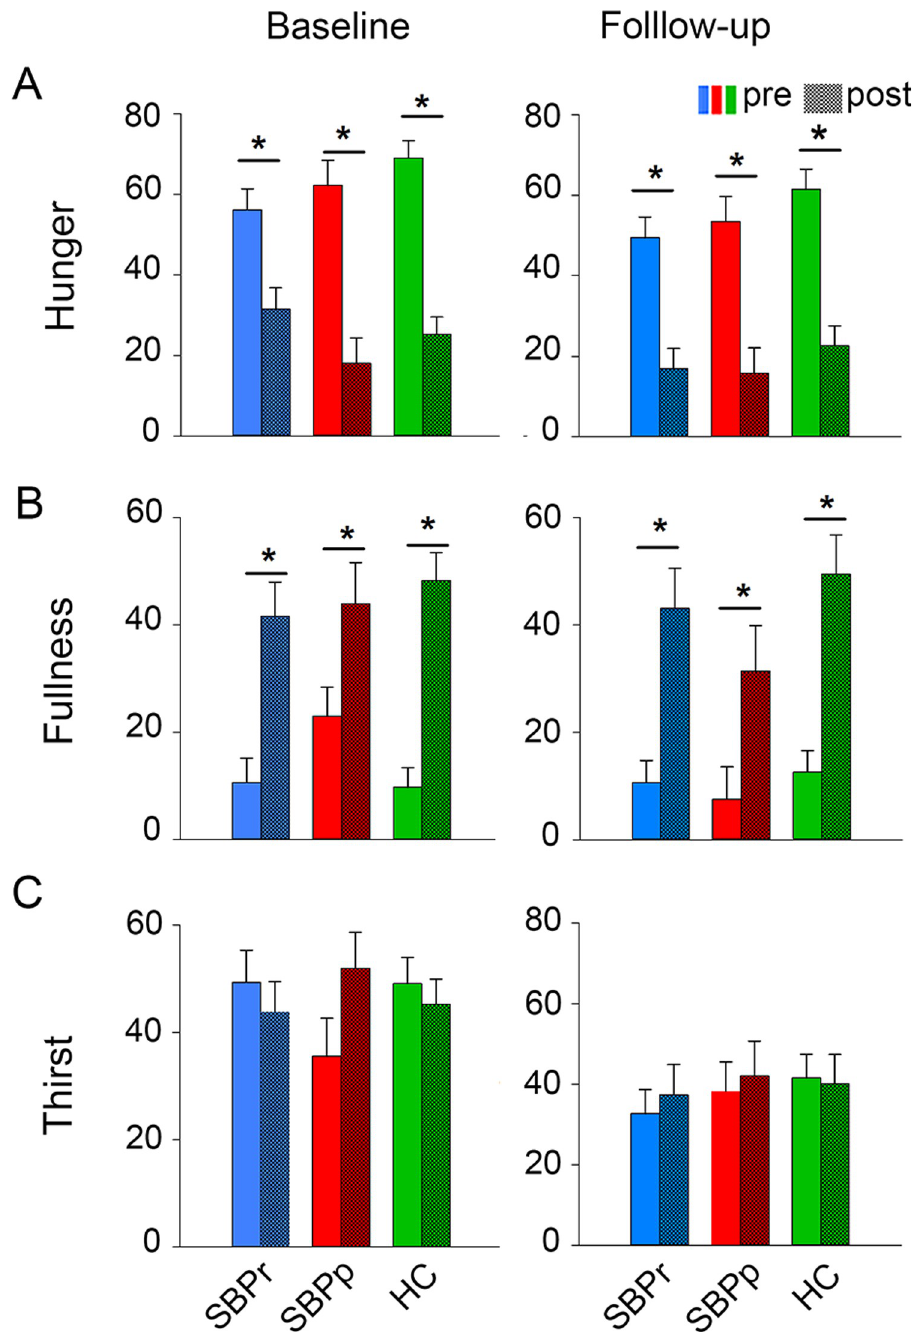
Fig 4. Internal state ratings before and after the ad libitum consumption of the preferred pudding during session 2. ( A ) Hunger, ( B ) Fullness, and ( C ) Thirst rated by SBPr, SBPp and HC (baseline, left; follow-up, right). There were no time or group effects in any of the analyses. Hunger and fullness ratings changed significantly after pudding consumption in all groups ( A-B ); thirst ratings did not differ following between groups or after consumption. There was no group or interaction effect during session